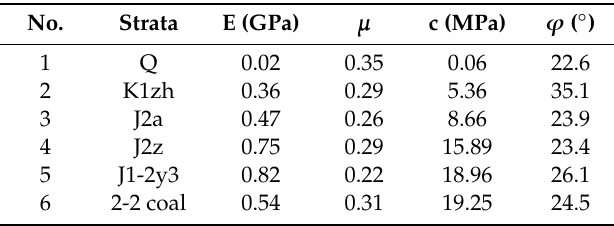
Table 5. The optimal mechanical parameters of overlying strata obtained by parameter inversion, according to Scheme 5 of Table